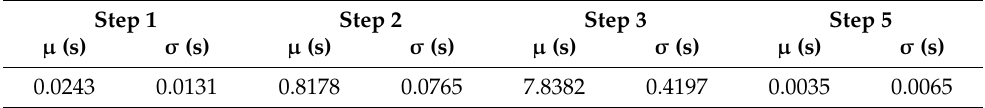
Table 2. Distribution of computational times for all steps excluding Step 4.